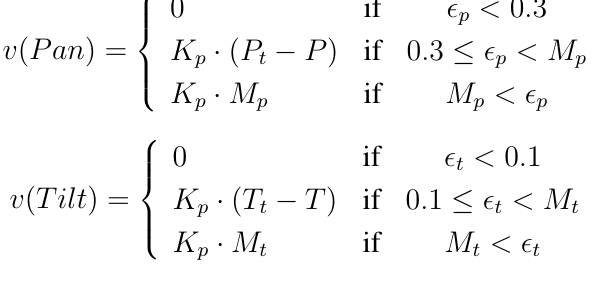
Figure 7. P-controller